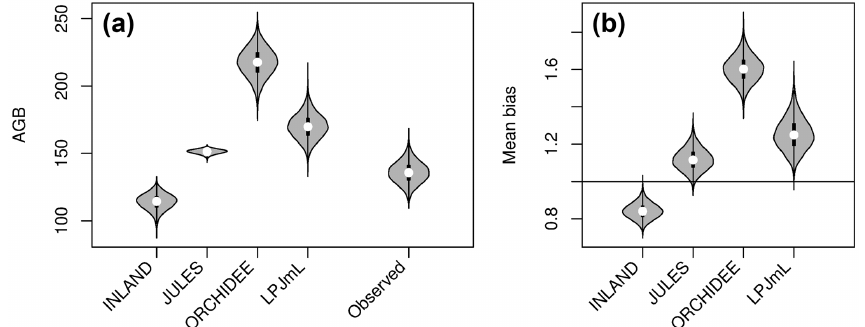
Figure 3. Distribution of aboveground biomass (AGB in MgCha − 1 ) from the four DGVMs and from the observational plots (see also Table S2 and S3). The figure shows (a) the mean value (white dot) and distribution from bootstrapping of absolute AGB values from the four simulations and observed data (grey violin shapes). (b) Mean bias as the ratio of mean simulated and mean observed AGB ( y/x) .